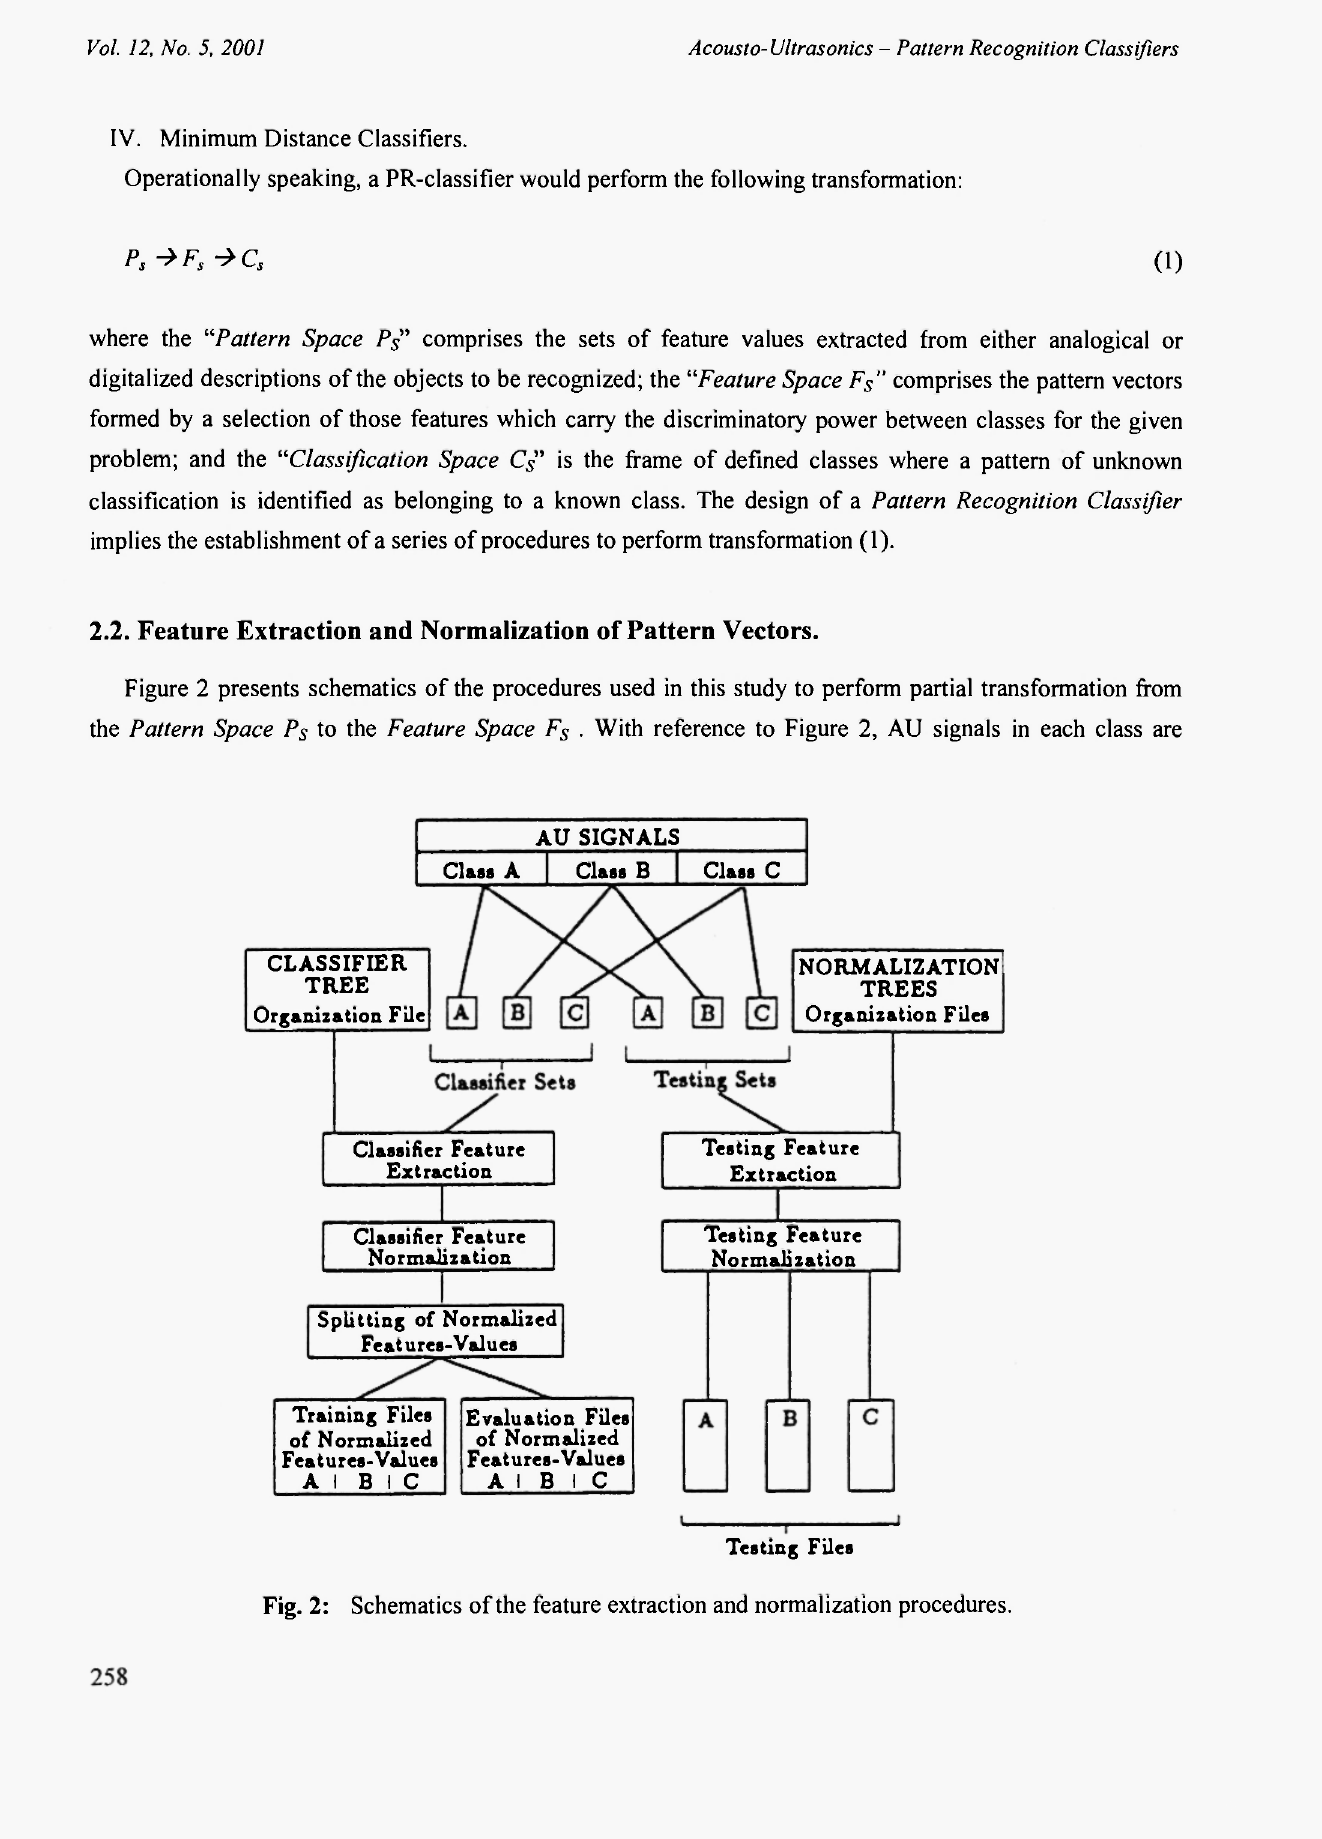
Fig. 2: Schematics of the feature extraction and normalization